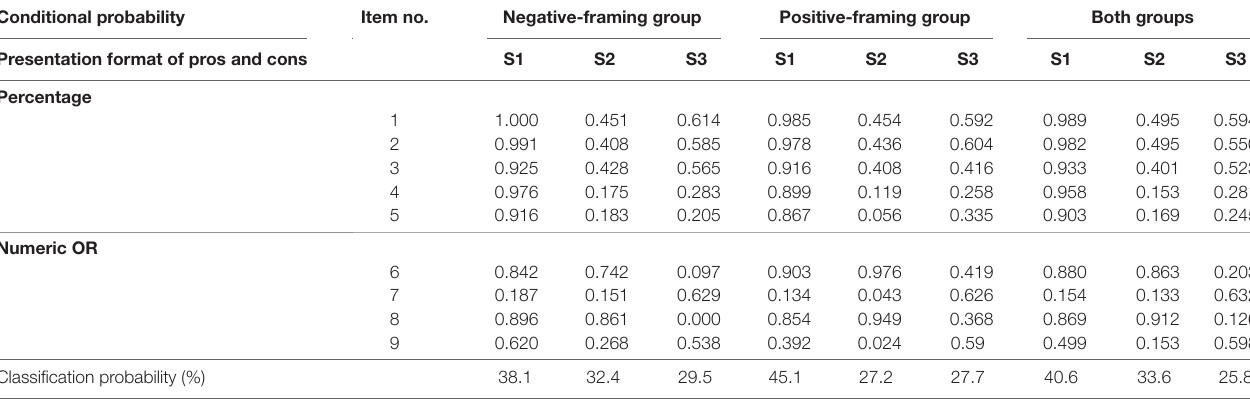
Table 3 | Conditional and classification probability of consent to thrombolysis in the negative-framing group, the positive-framing group, and both groups combined. conditional probability